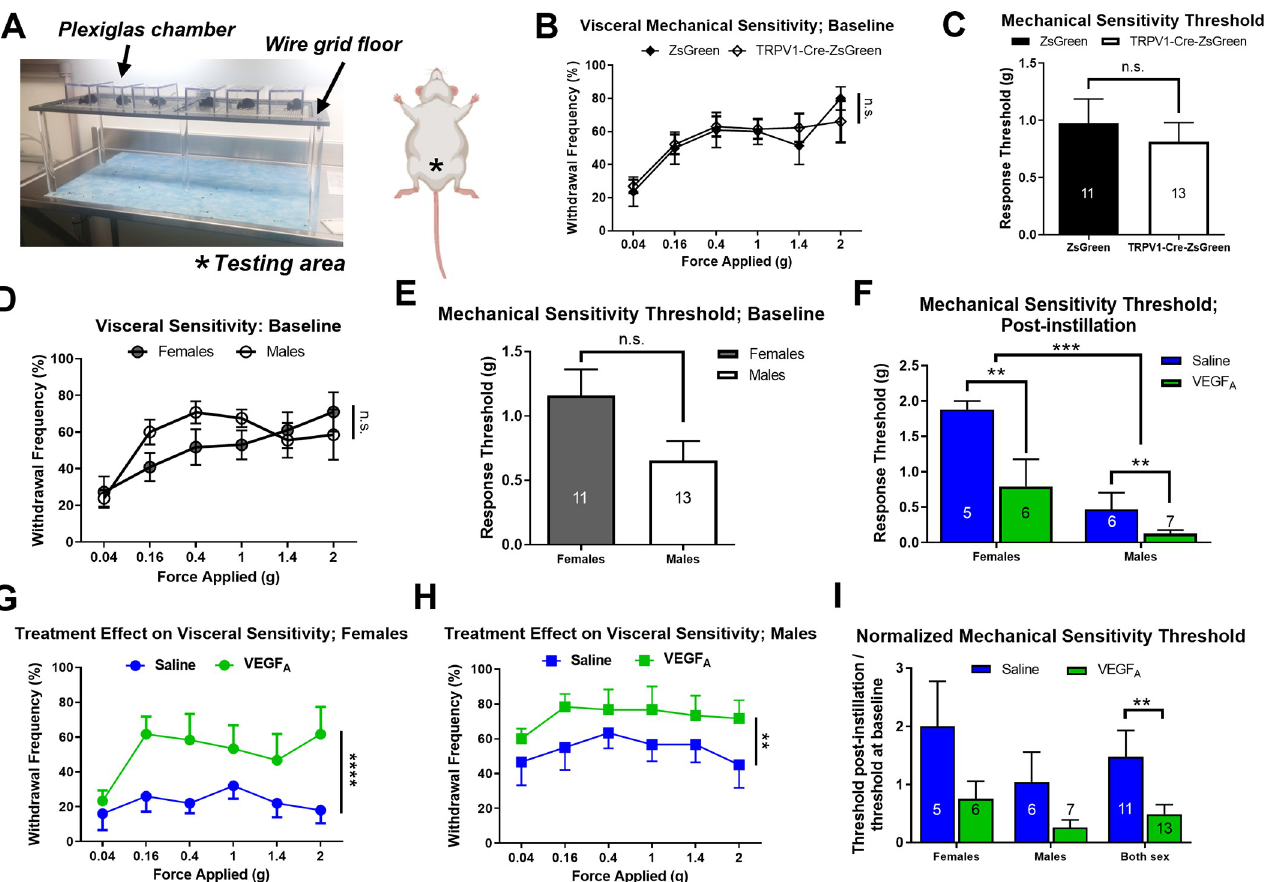
Fig 2. Intravesical instillation of VEGF A led to visceral mechanical hypersensitivity. (A). A set up for Von Frey testing. The star indicates the pelvic area where the filaments were applied to. (B). The withdrawal “frequency-response” curve showed no significant difference in baseline visceral mechanical sensitivity between TRPV1-Cre-ZsGreen mice and ZsGreen mice. (C). No significant differences were identified in the baseline response threshold between TRPV1-Cre- ZsGreen mice and ZsGreen mice. (D-E). No sex differences were identified in the baseline visceral mechanical sensitivity. (D). The withdrawal frequency- response curve at baseline. (E). The mechanical response threshold at baseline. (F). VEGF A -instillation lowered mechanical response threshold in both male and female mice. Male mice showed significantly lower response threshold to visceral mechanical stimulation than females. (G). VEGF A -instillation significantly increased the withdrawal frequencies to visceral mechanical stimulation in female mice. (H) VEGF A -instillation significantly increased the withdrawal frequencies to visceral mechanical stimulation in male mice. (I) Normalized response threshold showed no sex differences, but significant VEGF A - induced decreases in response threshold in B6 mice. Source of the schematic of mouse underside in Fig 2A: https://biorender.com/icon/species/rodents/mouse-supine- pregnant-1/.